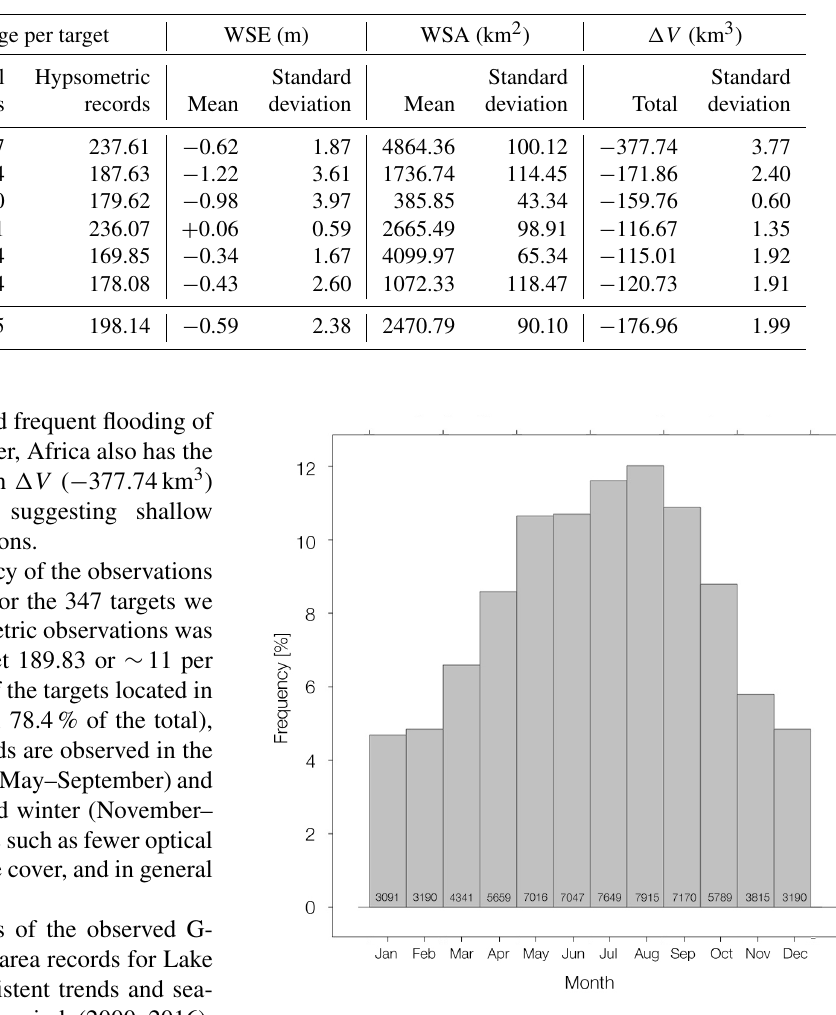
Figure 4. Monthly frequency of the observations used to create the hypsometric curve for the 347 targets analyzed in this study, with total number of observations for each